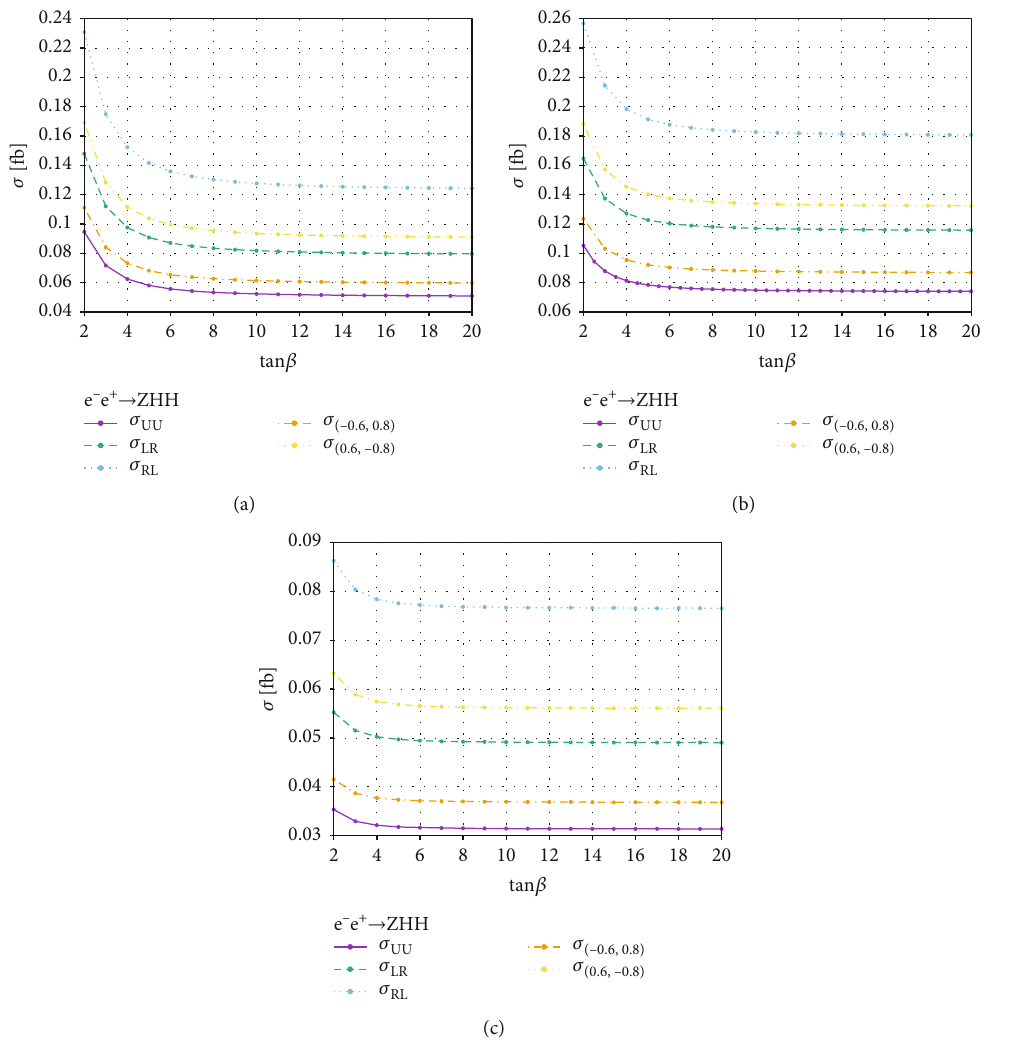
Figure 9: In fi gures, the production cross sections σ ð e + e − ⟶ ZHH Þ are shown as a function of tan β at (a) 0.6TeV, (b) 1 TeV, and (c) 3TeV